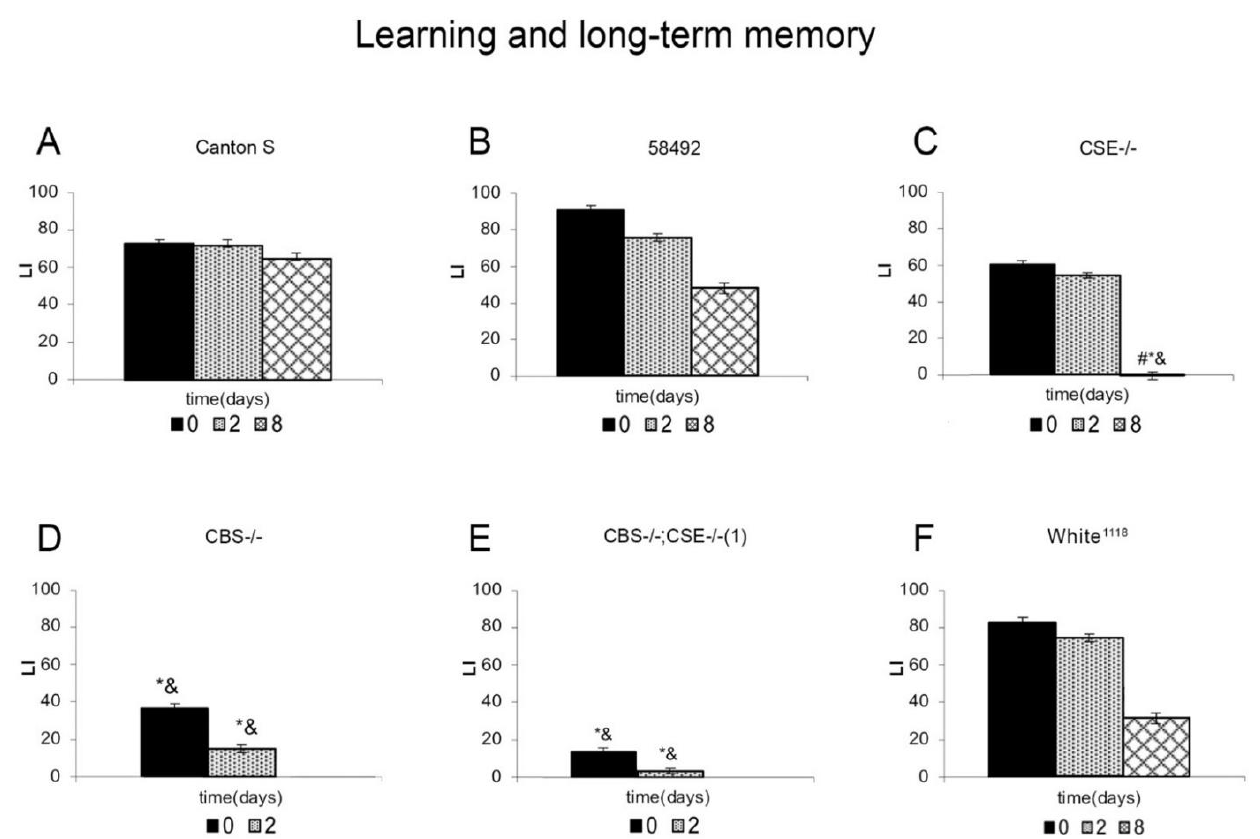
Figure 2. Dynamics of learning acquisition and long-term memory retention of conditioned courtship suppression in mutant males. Males from Canton-S ( A ), 58492 ( B ), CSE-/- ( C ), CBS-/- ( D ), CBS-/- ; CSE-/- (1) ( E ), and white 1118 ( F ) strains were tested. Abscissa: time after training (days); ordinate: LI—learning index, standard units. The sample size for each time point was 20 males. *—LI significantly lower than that 58492 strain under similar conditions (two-sided randomization test, α R < 0.05); &—LI significantly lower than that of wild type Canton-S strain under similar conditions (two-sided randomization test, α R < 0.05); and #—LI in the delayed test significantly lower than in test immediately following training (two-sided randomization test, α R < 0.05).